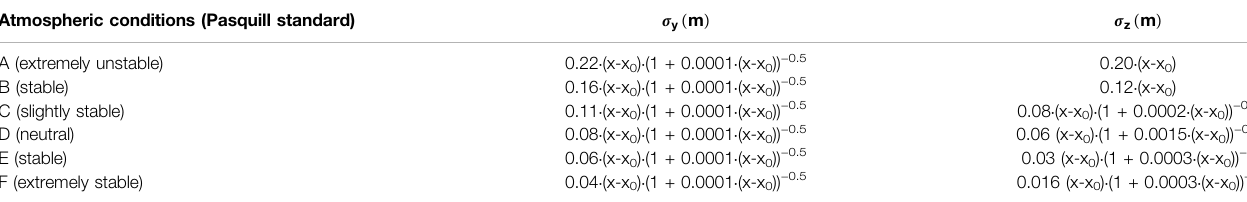
TABLE 1 | Dispersion parameter schemes established by BRRIGS. Atmospheric conditions (Pasquill